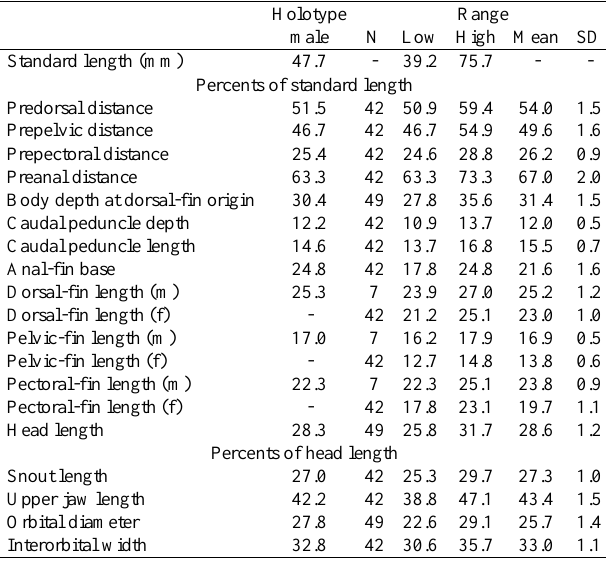
Table 1. Morphometric data of Astyanax jordanensis based on the holotype and paratypes. N = number of specimens analyzed, including holotype, SD = standard deviation, m = male, f = female.